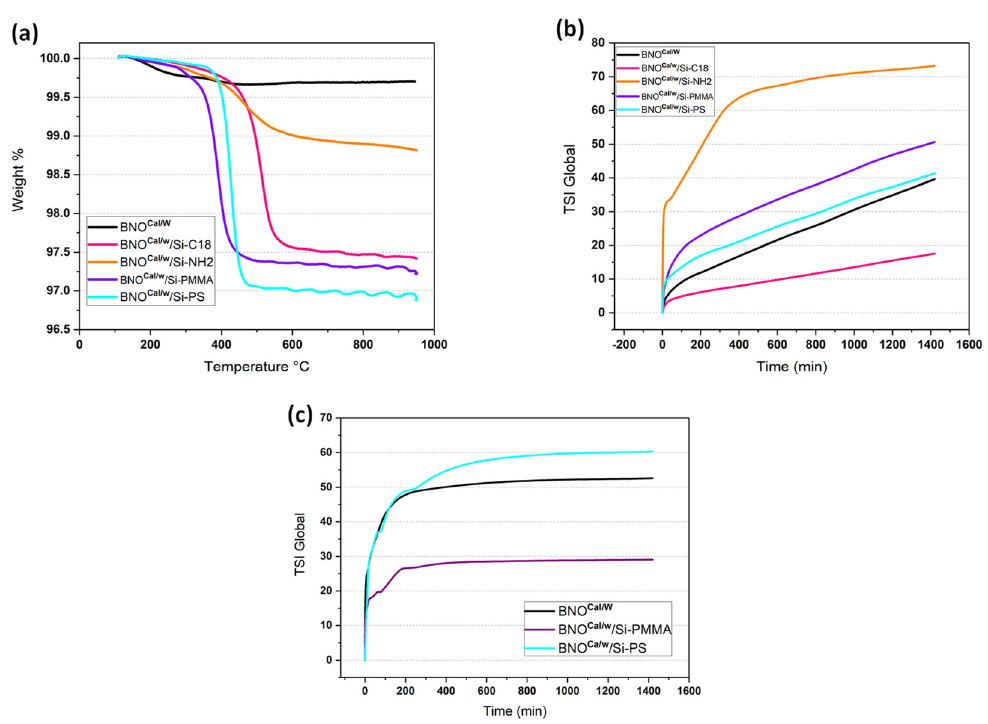
Figure 11. ( a ) TGA of grafted BNO Cal/W compared with that of BNO Cal/W . ( b ) TSI global in water and ( c ) TSI global in toluene for BNO Cal/W and grafted BNO Cal/W . and ( c ) TSI global in toluene for BNO Cal/W and grafted BNO Cal/W